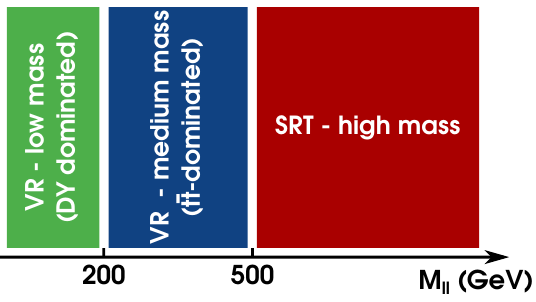
Figure 3 . De(cid:12)nition of the two validation regions (VR) and the high-mass signal region (SRT).